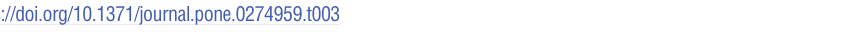
The number of mice responding to PP effluent from FSGS patients, with proteinuria exceeding the mean plus 3 times the standard deviation of proteinuria of healthy plasma-injected mice, as shown in Fig